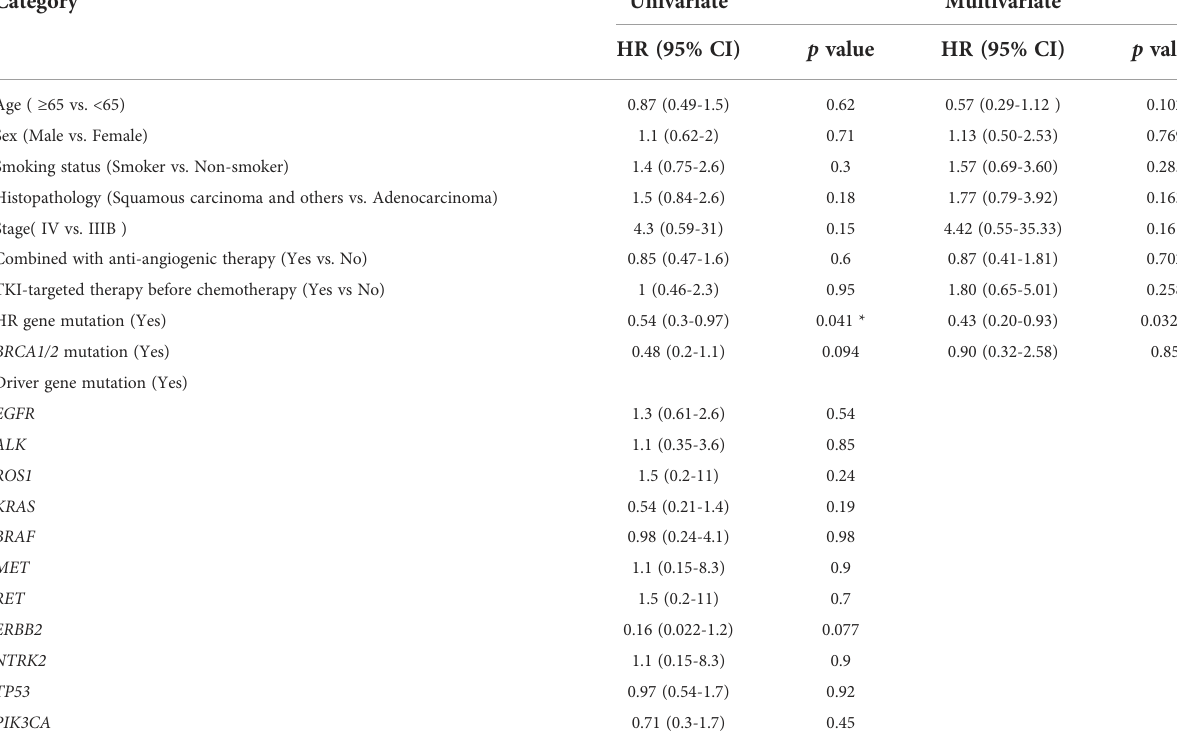
TABLE 3 Univariate and multivariate Cox proportional hazard regression analysis of potential factors associated with progression-free survival. Category